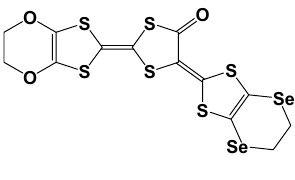
Figure 19. The chemical structure of ethylenedioxy-ethylenediseleno-tetrathiafulvaleno-